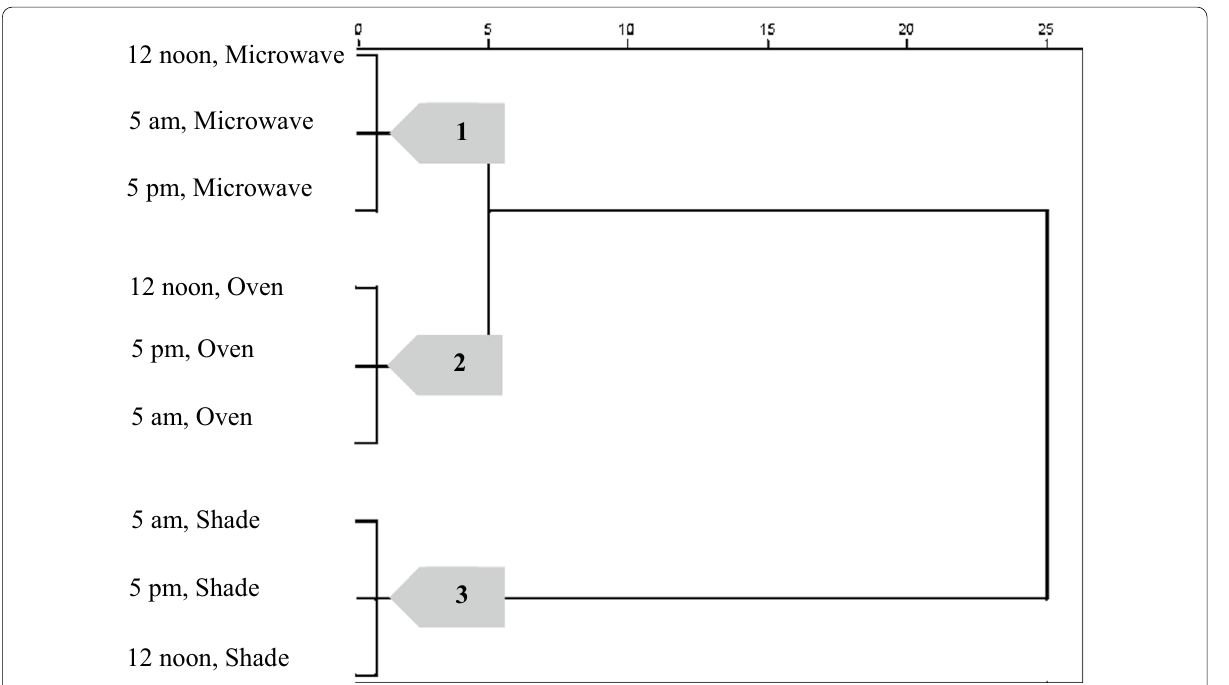
Fig. 4 Cluster analysis of the treatments based on the all evaluated phytochemical